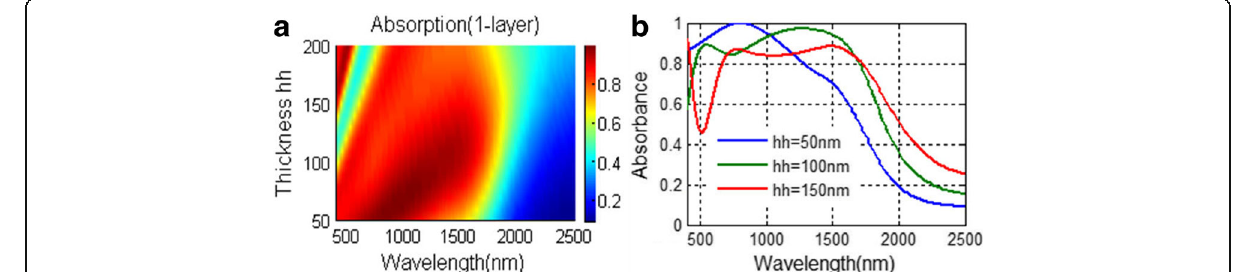
Fig. 2 a , b Absorbing performance for one-layer NPA varying with dielectric thickness hh